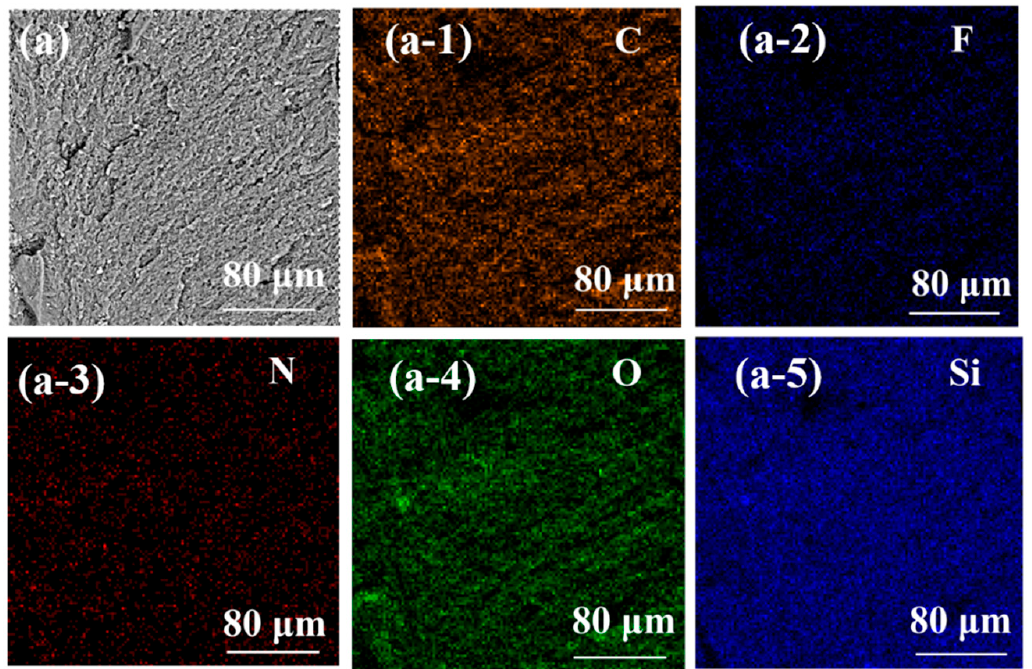
Figure 7. ( a ) The SEM microstructure for the cross-section of the printed SiO 2 @TSPI composite film; ( a-1 )–( a-5 ) the EDS results for the printed SiO 2 @TSPI composite.